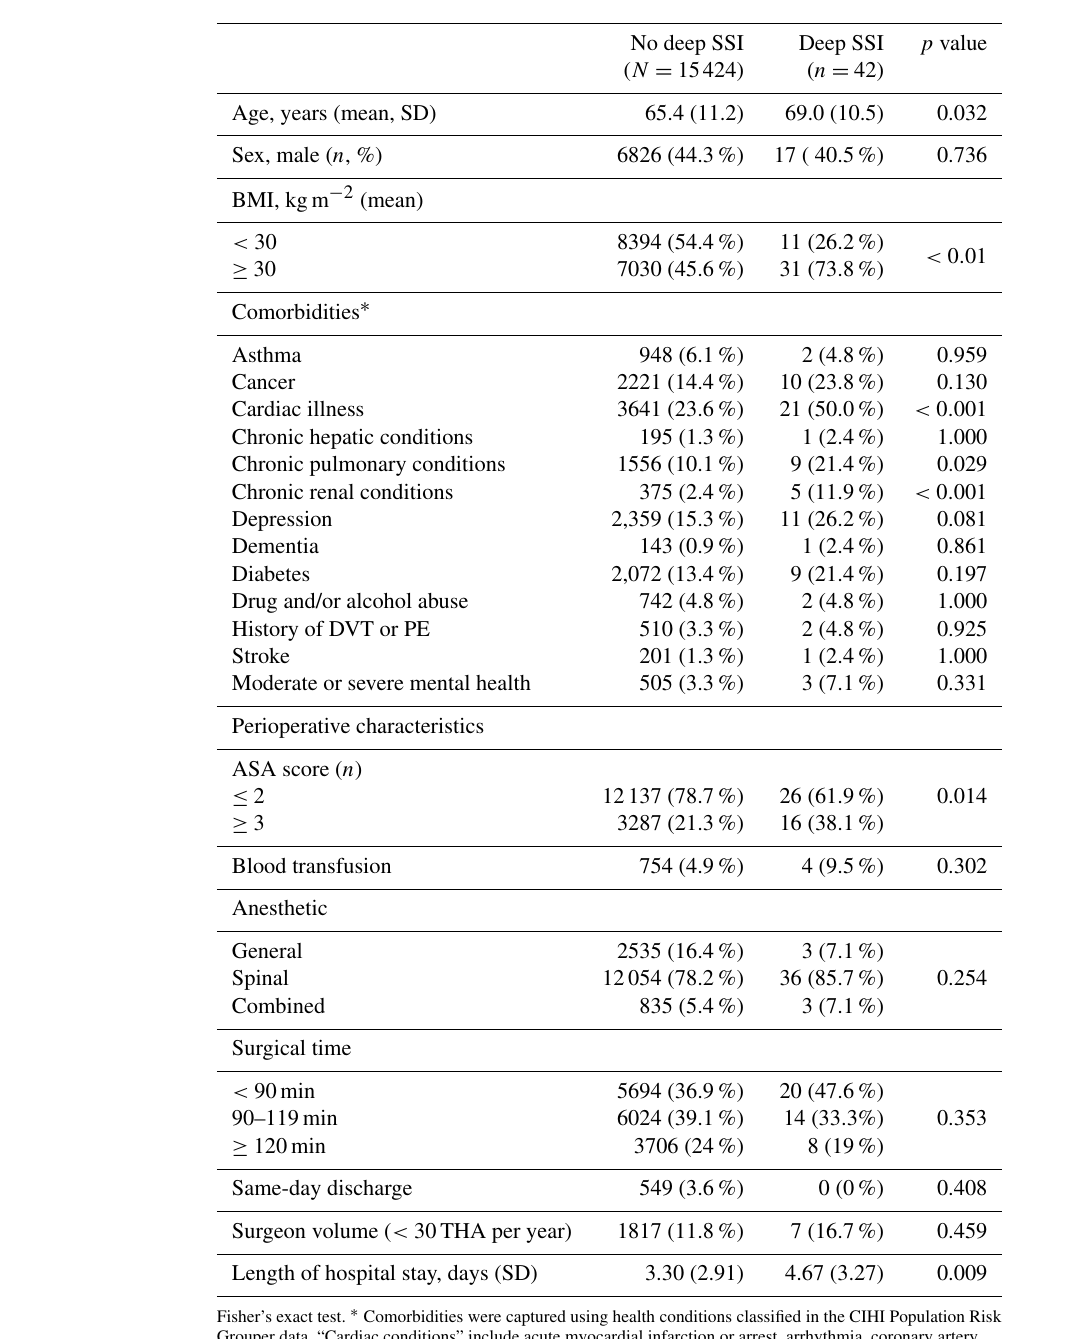
Table 3. Patient demographics and surgery